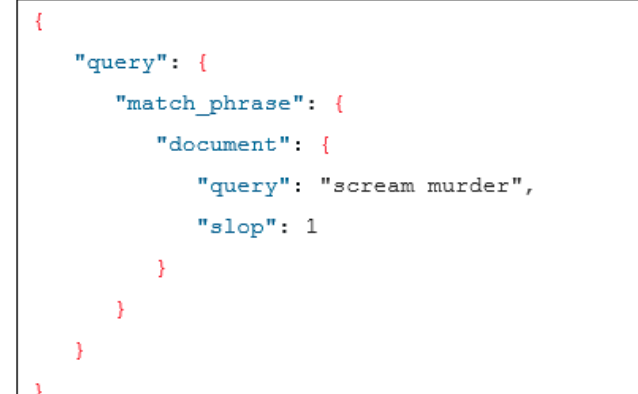
Figure 4. An example of a proximity query.